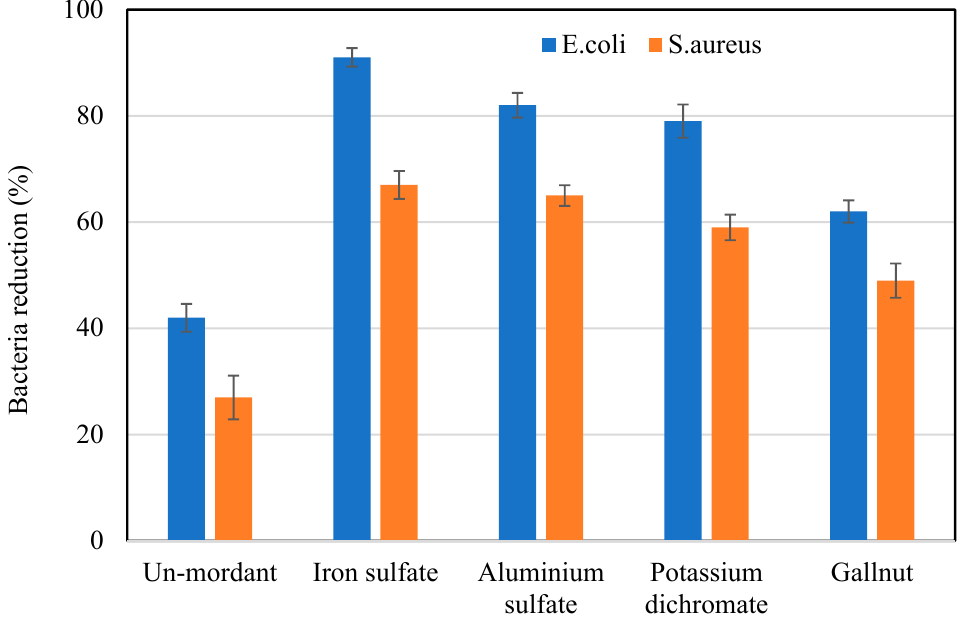
Figure 4. The antibacterial rates of dyed polyamide fabrics against bacteria strains.